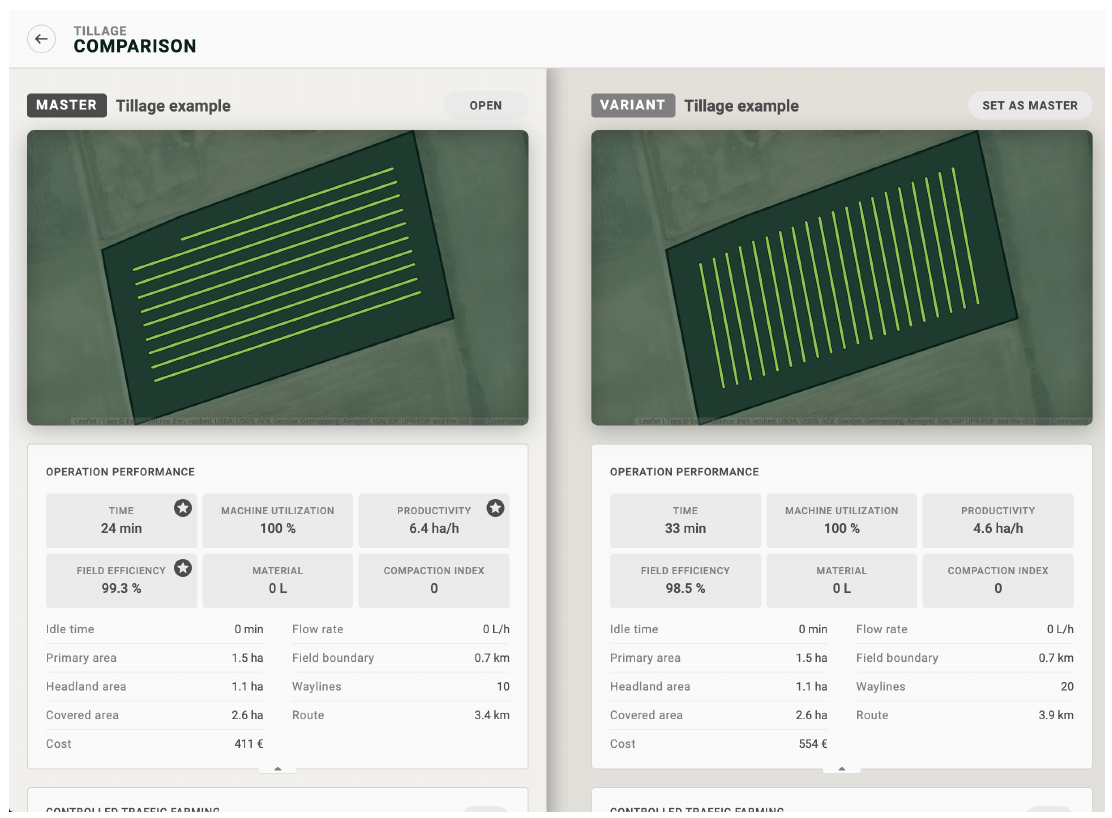
Figure 6. Comparison view for different plan configurations for a tillage